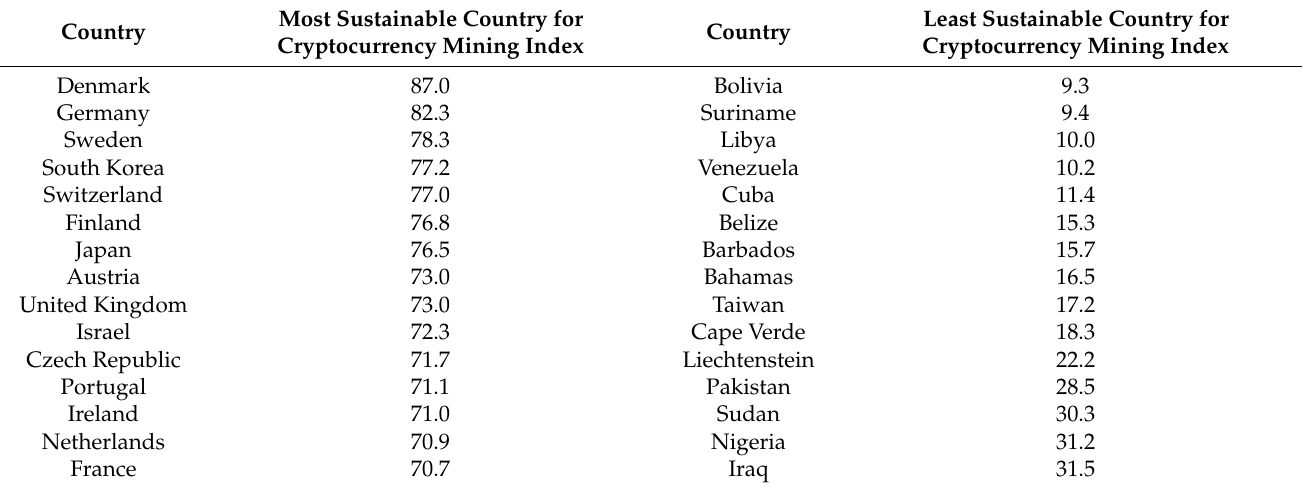
Figure 2. Most sustainable countries for cryptocurrency mining. Source: Own elaboration using Tableau Desktop Professional Edition. Table 5. Most and least sustainable countries for cryptocurrency mining